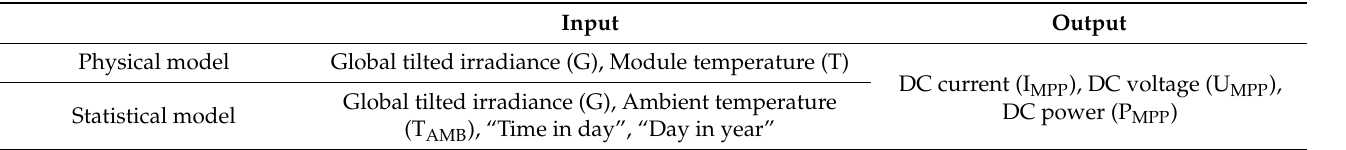
Table 2. Input and output summary for the physical and statistical models.